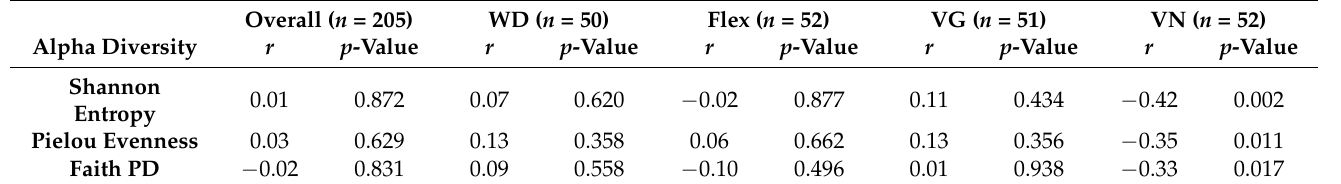
Table 8. Pearson correlation between energy intake (kcal/day) and alpha diversity in diet types.